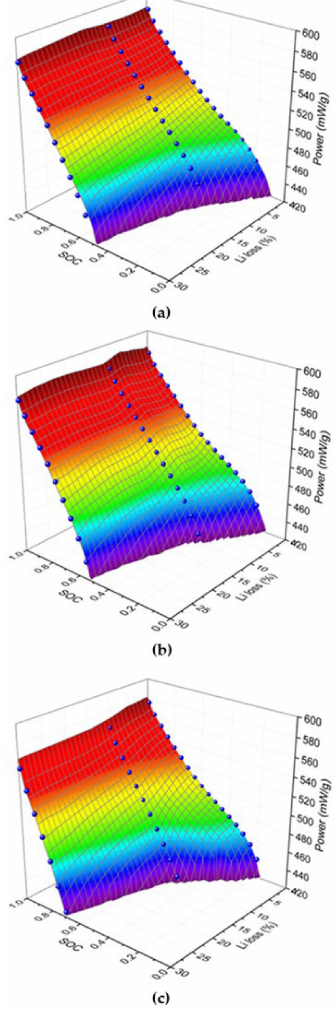
Figure 8. Three-dimensional graphs of the discharge power with respect to SOC and cyclable lithium loss at a discharge-current rate of 0.5 C for electrolyte volumes of ( a ) 20, ( b ) 15, and ( c ) 10 µ L; 3D surface plots represent the modeling results, and the spheres represent the experimental